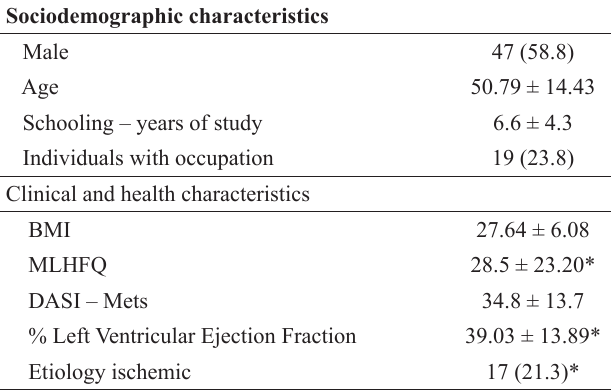
Table 1. Characterization of the sample according to sociode - mographic, clinical and health characteristics, and sedentary behavior and physical activity n =